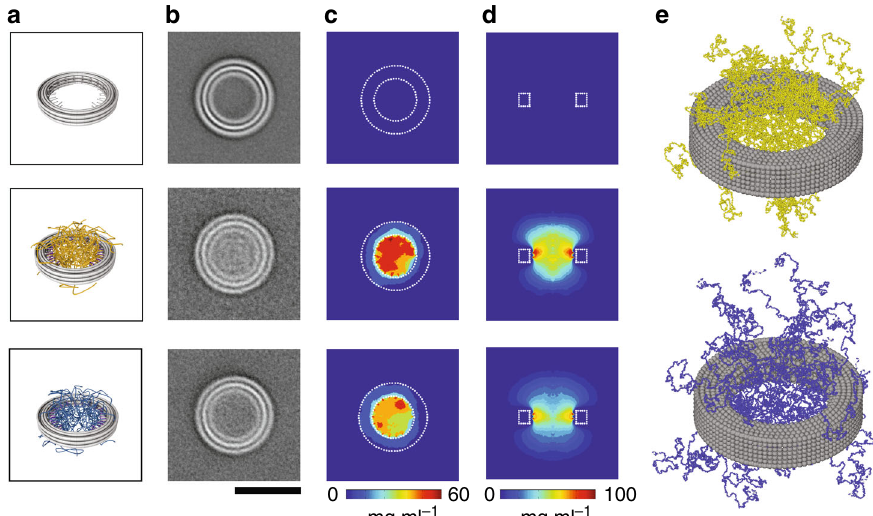
Fig. 3 Spatial distribution of FG-Nup densities in DNA rings from cryo-EM and MD simulations. a Schematic representation of (top to bottom): empty ring, 32- NSP1, and 32-NSP1-S. b Corresponding average obtained from aligning and summing individual cryo-EM particles. Number of averaged particles: Ring = 1663, NSP1 = 637, NSP1-S = 1051. See Supplementary Figure 8 for exemplary particles. Scale bar = 50nm. c , d Time-averaged mass densities of proteins inside the DNA ring obtained from coarse-grained MD simulations averaged in the z -direction, shown in top view ( c ) and side view ( d ). e Exemplary snapshot of MD simulations of 32-NSP1 (top) and 32-NSP1-S (bottom), showing that NSP1-S proteins extend further out than